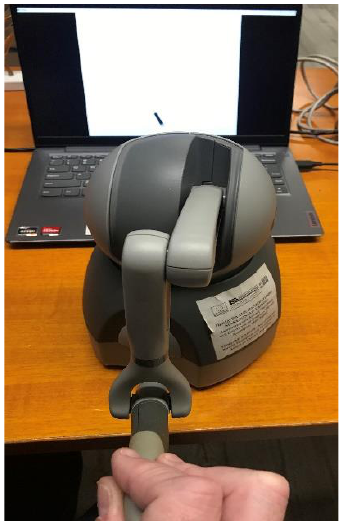
Figure 1. A participant sitting in front of a portable computer using the Touch.